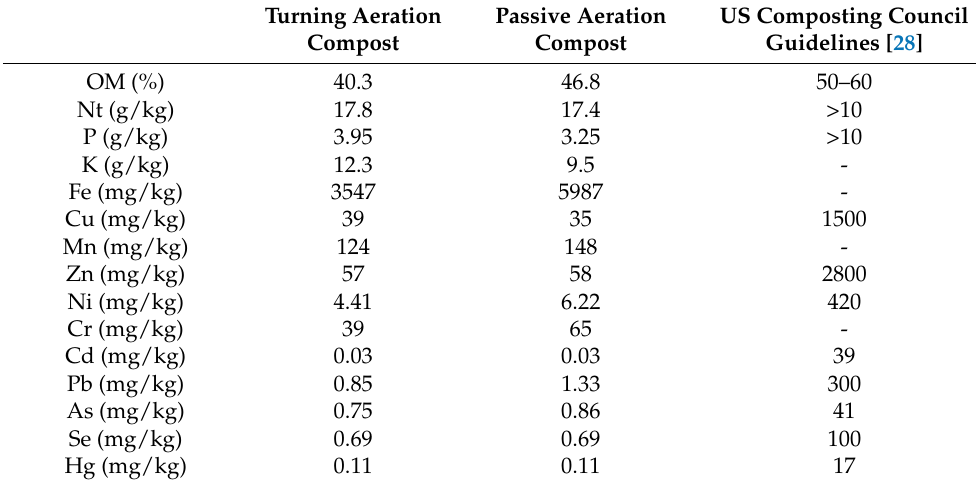
Table 7. Agronomic characteristics of the composts